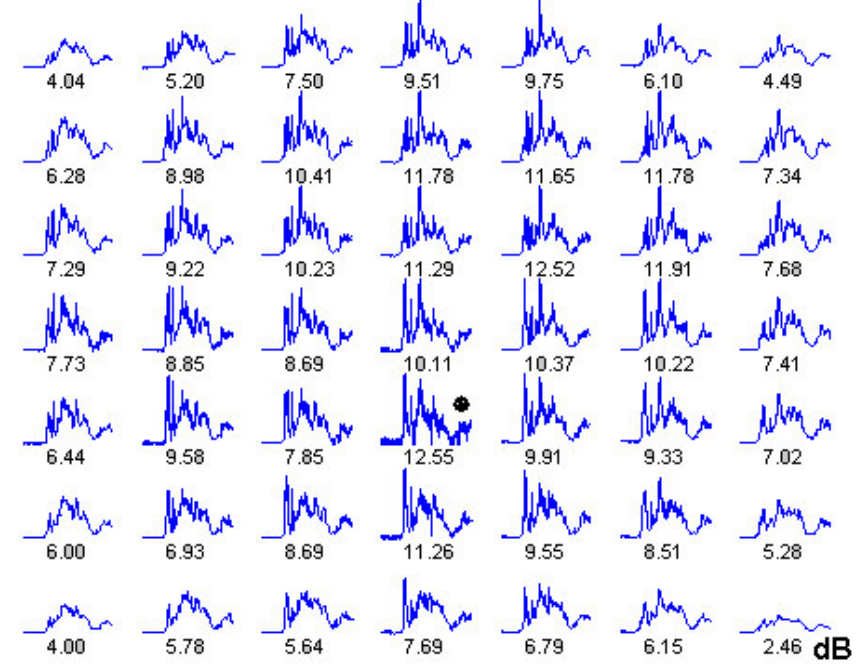
Fig. 11. A typical type IV spike event in IRIS FoV. Event occurred in 30 October 1994 19:30–20:30 UT (22:15–23:15 MLT). Numbers are the peaks of spikes in each narrow-beam in dB at 10-s resolution. Black spot in the middle marks the narrow-beam in which the most intense spike